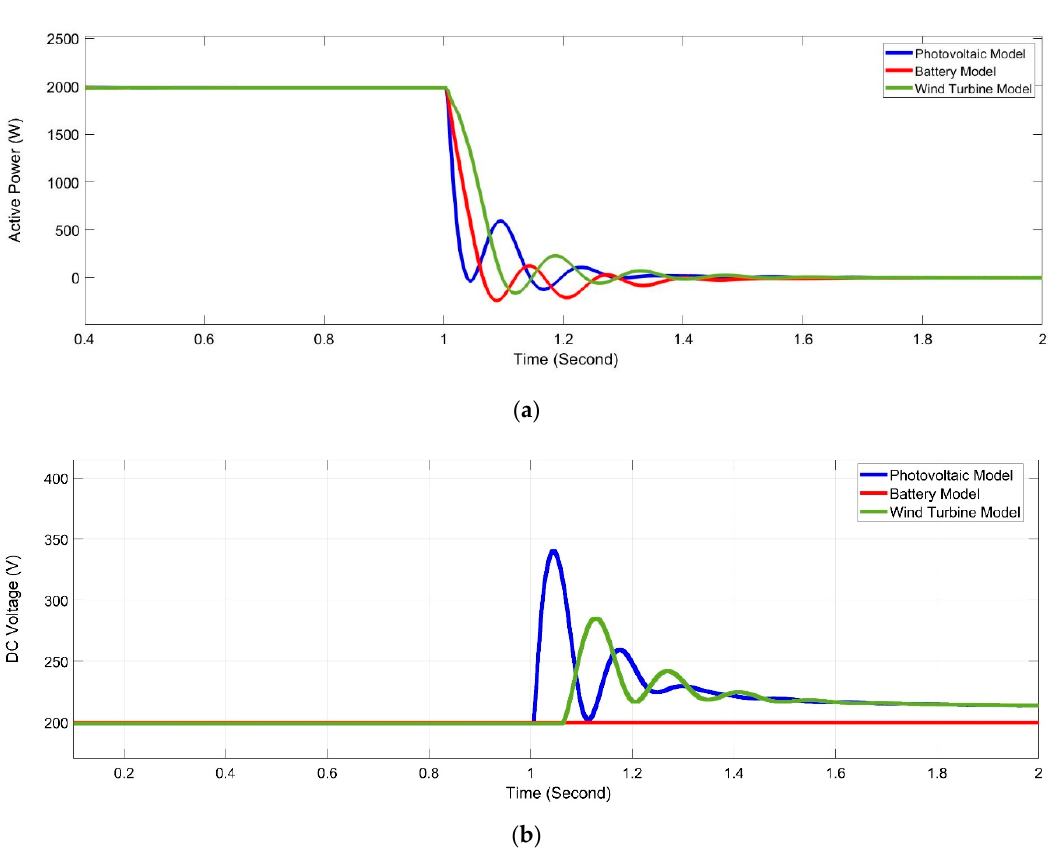
Figure 21. The method shown in Figure 17a is used, where ( a ) is the response of averaged power, ( b ) is the DC link voltage